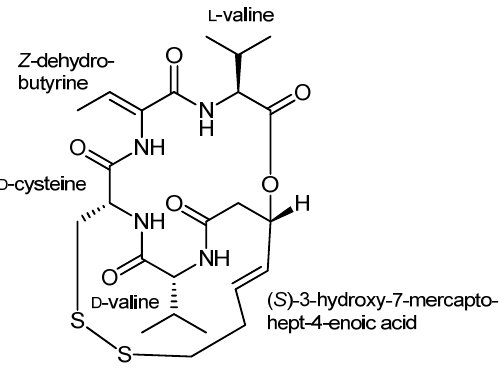
Figure 2. Chemical structure of the histone deacetylase inhibitor